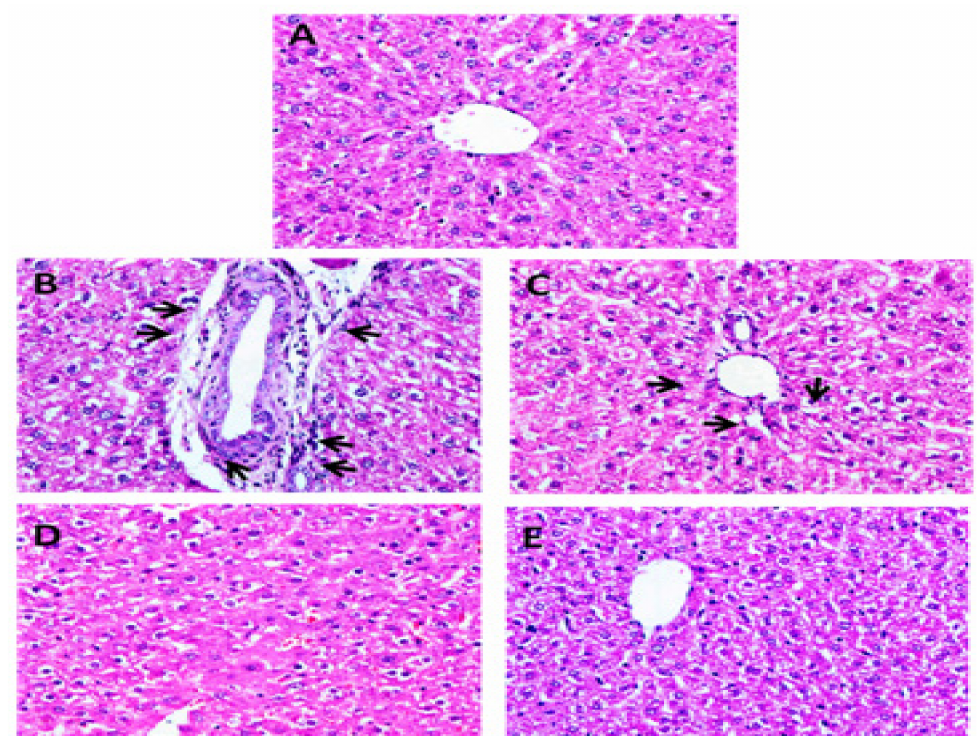
Figure 7. Liver histopathological architecture of rats treated with Carum carvi. Representative micro- graphs (original magnification: 40 × ) showing alterations in liver histopathology by acetaminophen and normalization of the anatomical architecture by Carum carvi treatment. Arrows represent diffuse vacuola- tion and infiltration of mononuclear inflammatory cells. ( A ) Control group. ( B ) Acetaminophen-treated group. ( C ) Acetaminophen + Carum carvi (100 mg/kg). ( D ) Acetaminophen + Carum carvi (200 mg/kg). ( E ) Only Carum carvi (200